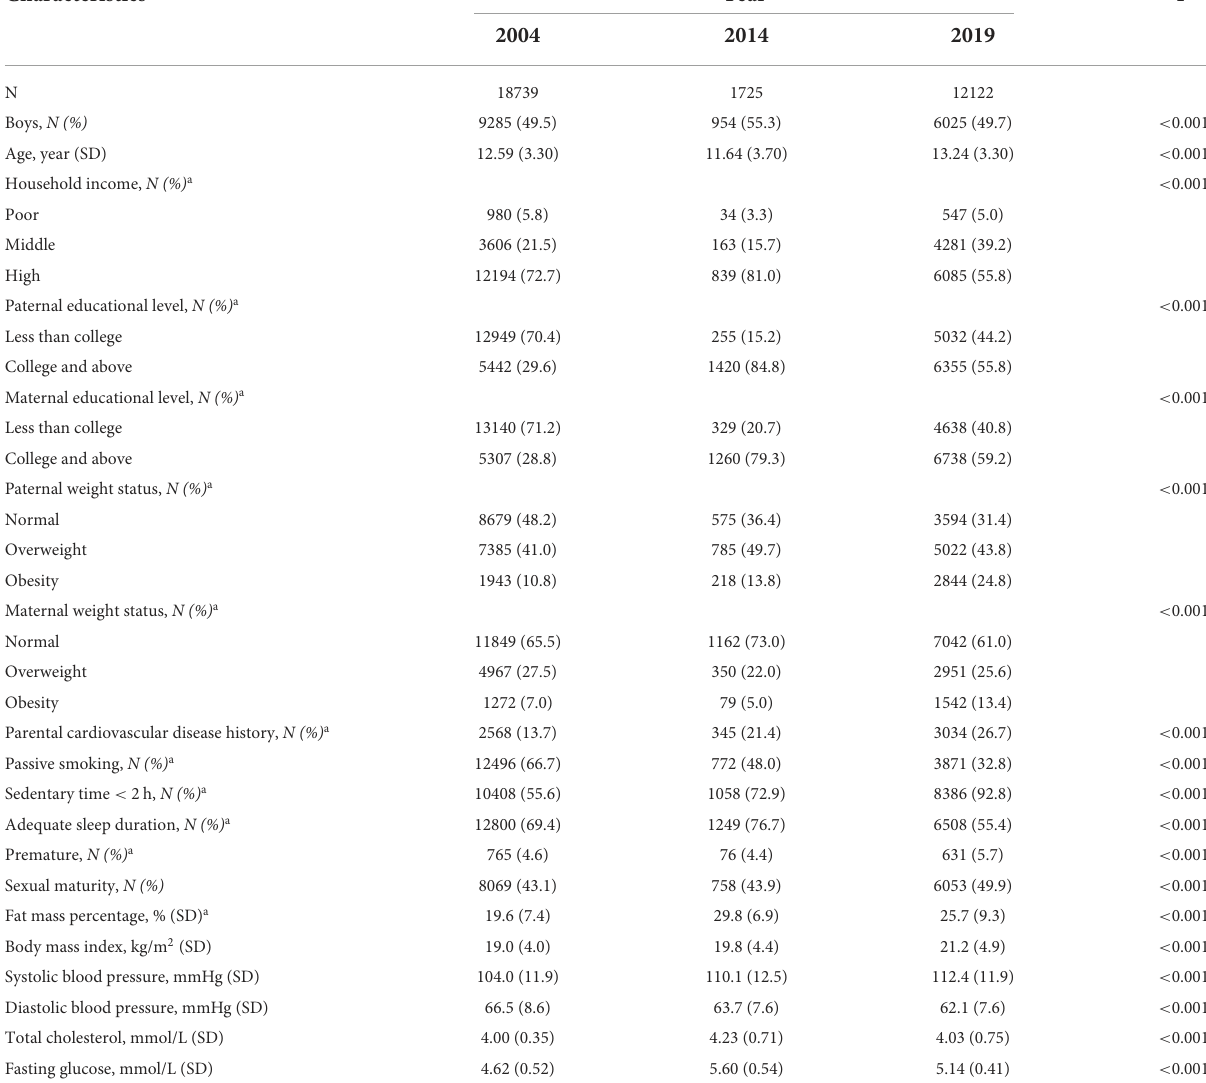
TABLE 2 Characteristics of participants by survey